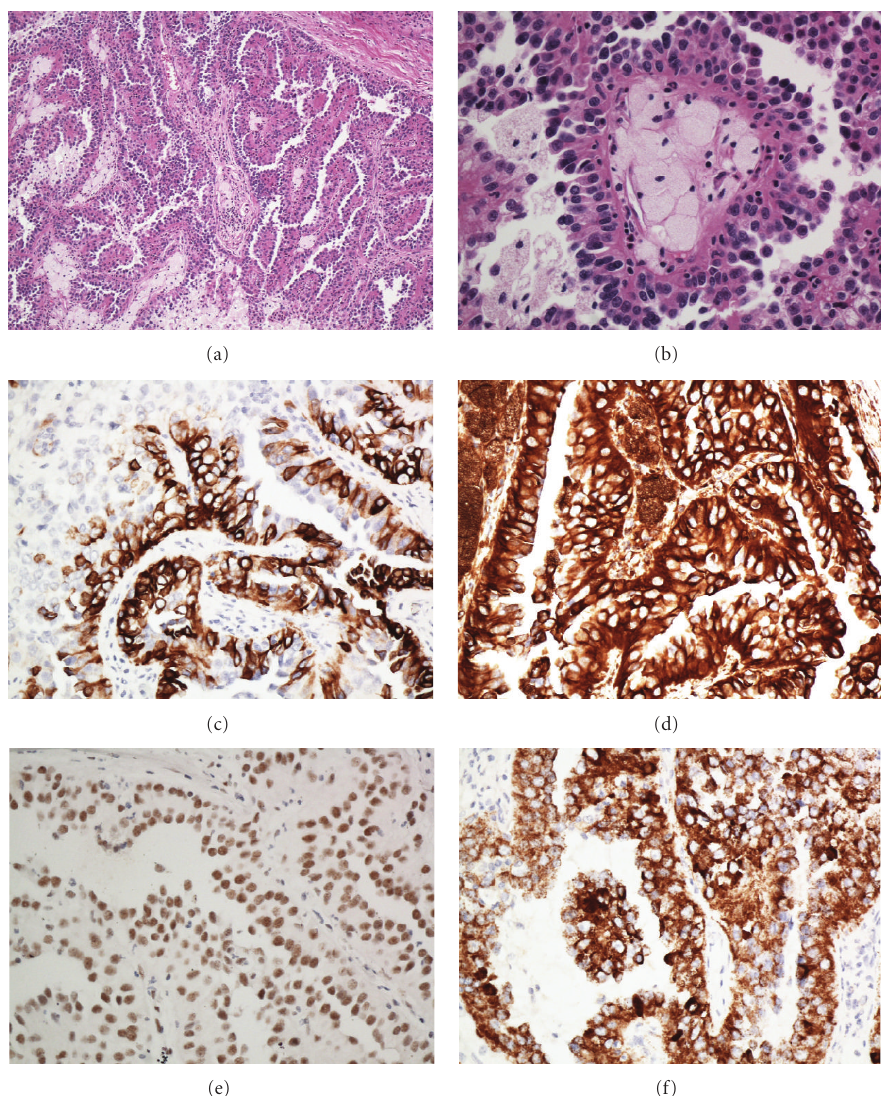
Figure 1: Histological and immunohistochemical features of the papillary renal cell carcinoma. Low-power view shows the papillary structures with fibrovascular cores ((a), original magnification 100x). The columnar neoplastic cells have finely granular eosinophilic cytoplasm, bland nuclear feature. Foamy histiocytes are seen within the fibrovascular cores ((b), original magnification 400x). The neoplastic cells are positive for CK7 (c), vimentin (d), PAX-2 (e), and AMACR (f) (original magnification